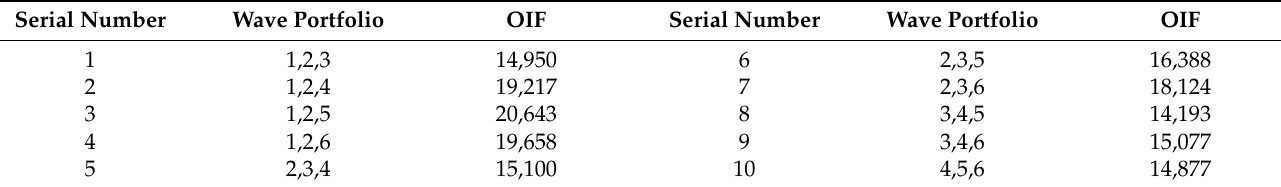
Table 3. OIF values for each